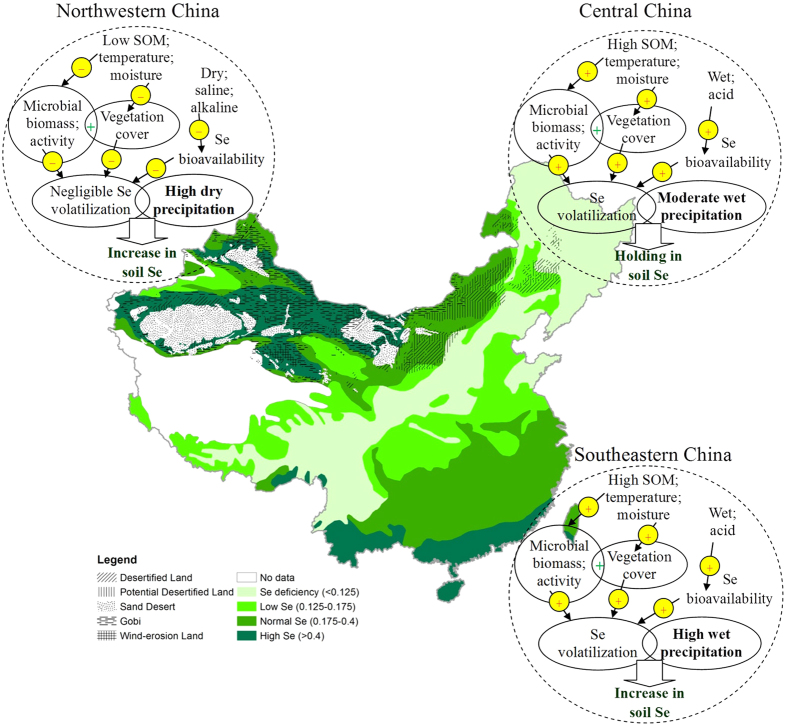
Schematic diagram of major factors and their potential impacts on soil Se volatilization in China, and the effects of volatilization and wet/dry deposition on the distribution of soil Se.SOM refer to soil organic matter. The maps were created using Arc GIS Geographic Information Systems software version 10.2 (Environmental Systems Research Institute Inc, Redlands, Calif).